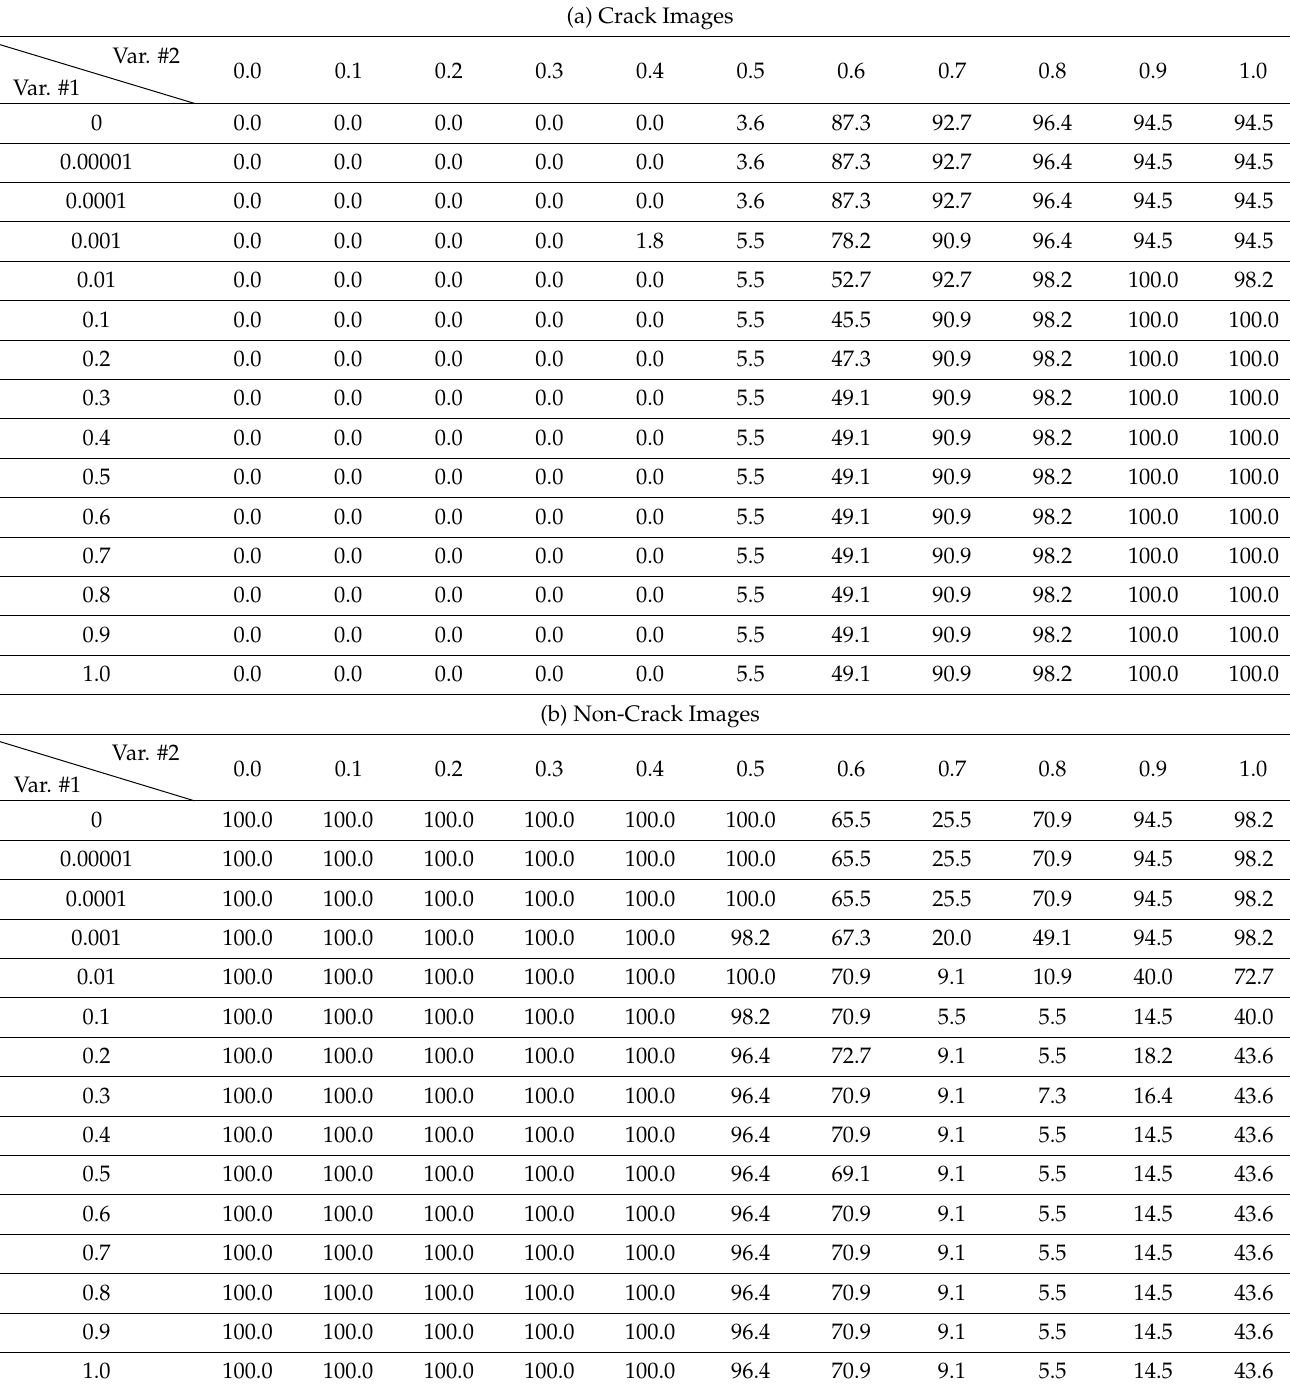
Table 4. Analysis results (%) by Var. #1 vs. Var. #2 (Var. #3: Mean). (a) Crack